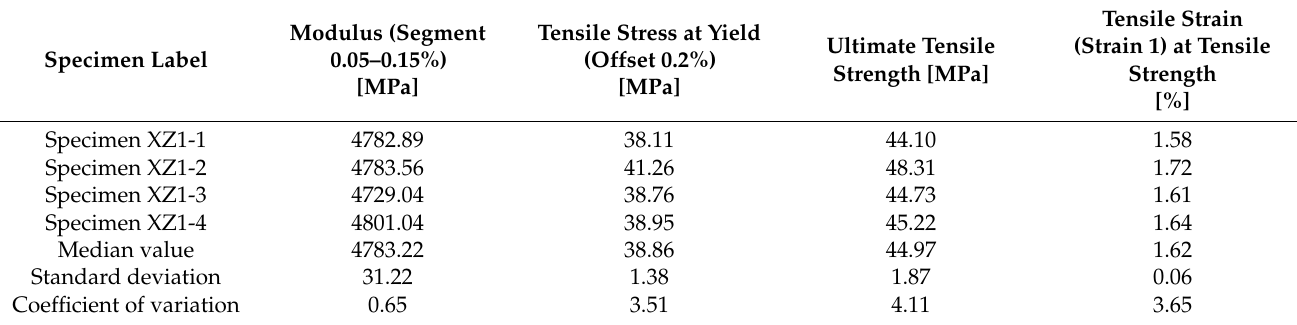
Table 3. Mechanical characteristics obtained for the XZ1 specimens.